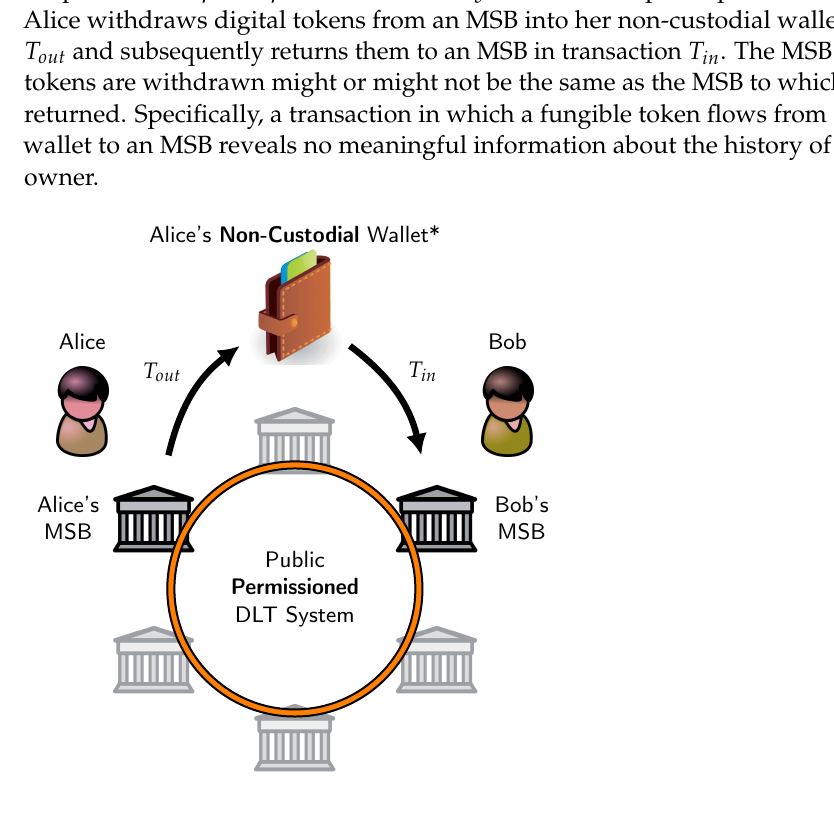
Figure 2. Schematic representation of the system